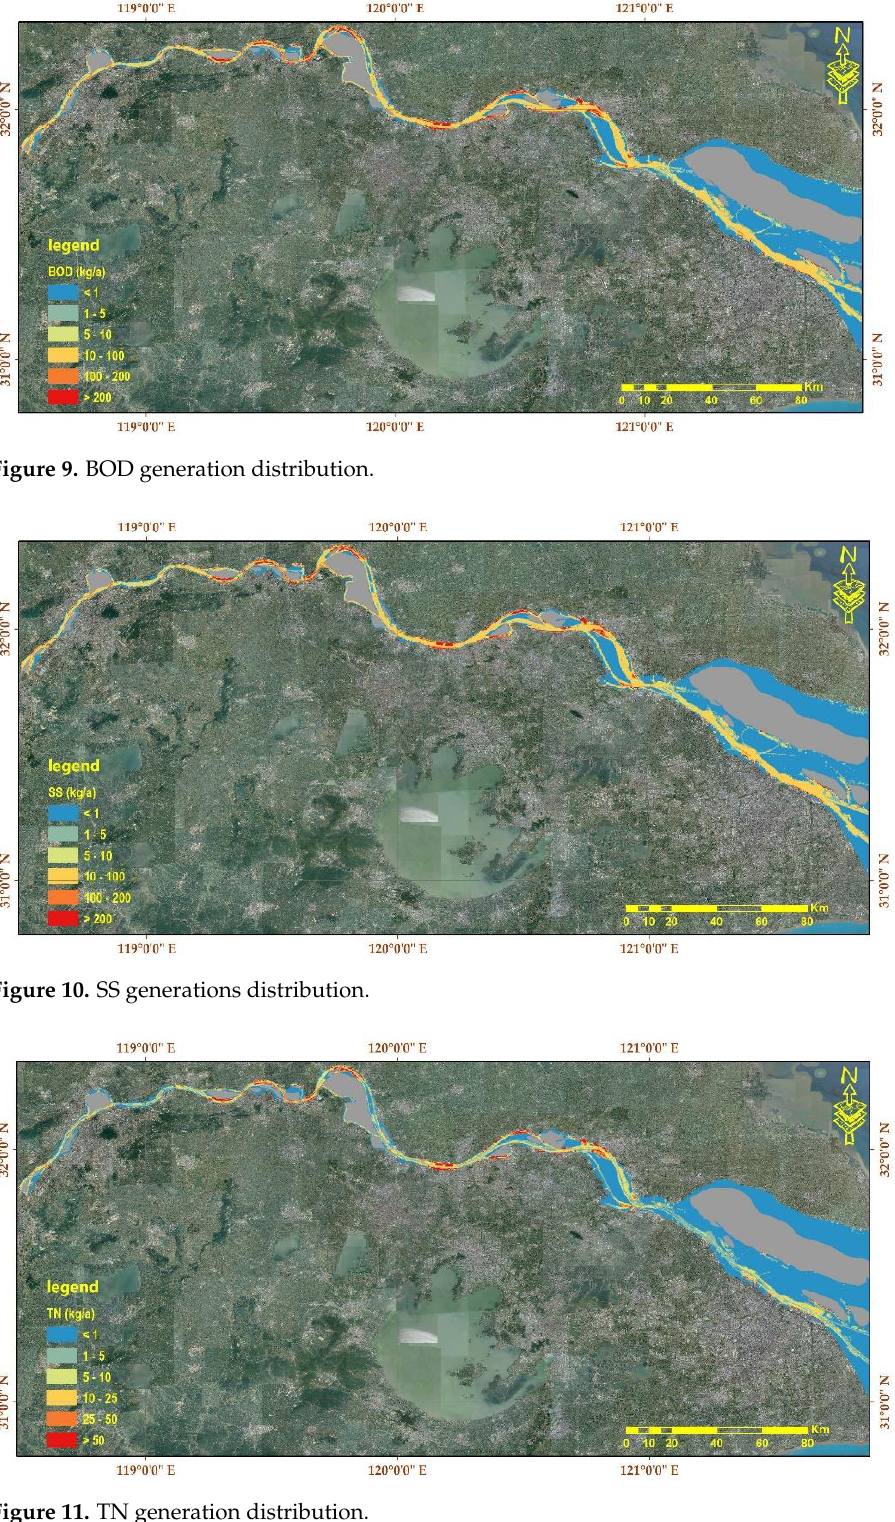
Figure 11. TN generation distribution.